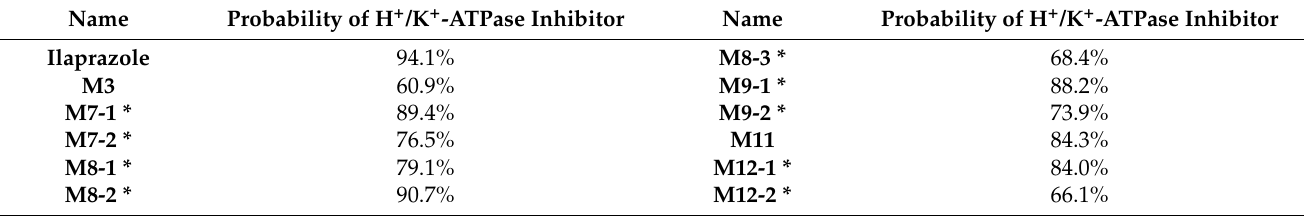
Table 1. In silico bioactivity prediction of the new